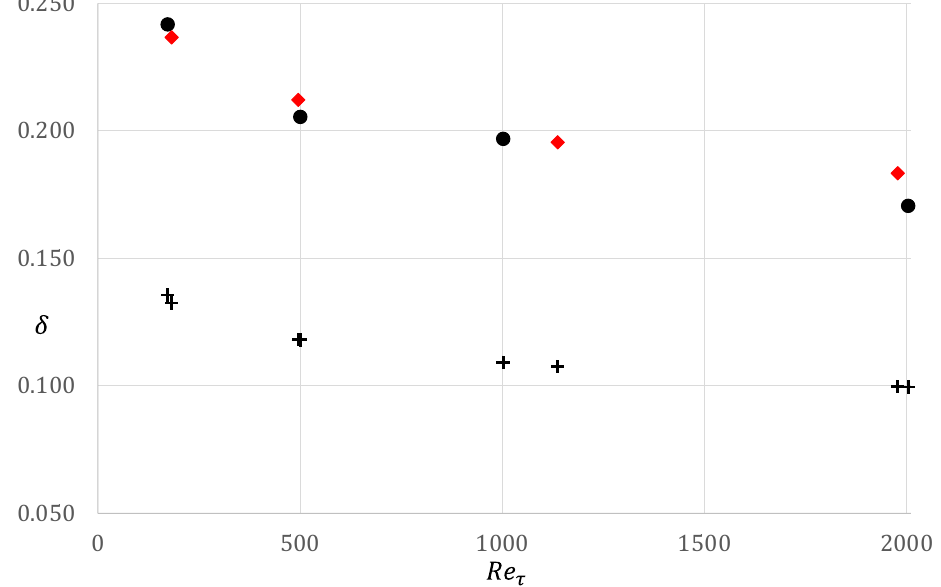
2000 ; • pipe DNS data [26]; pipe DNS data [31,32]; ♦ 𝛿𝛿